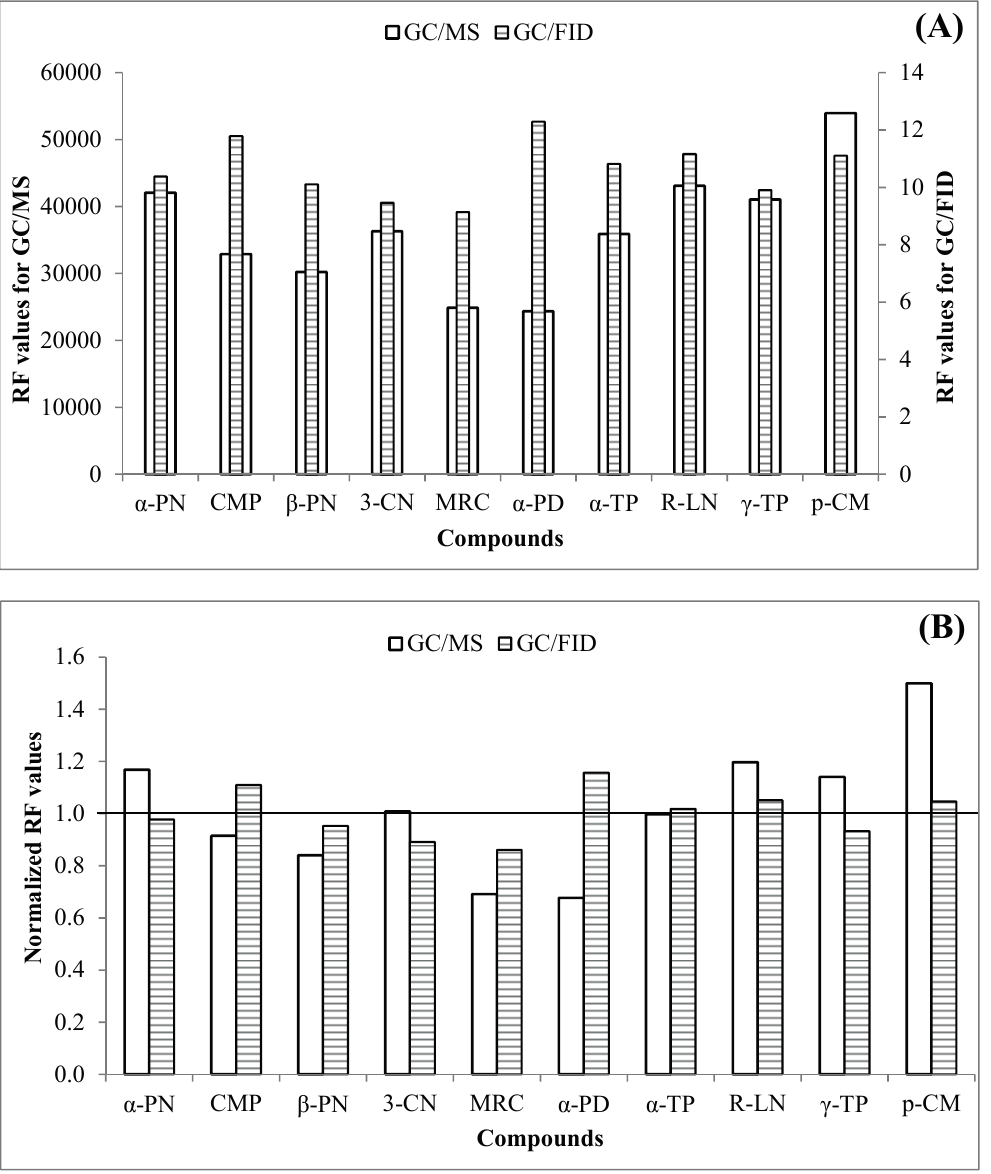
Figure 3. Comparison of both ( A ) absolute and ( B ) normalized response factor (RF) values of all target MTs between GC/MS and